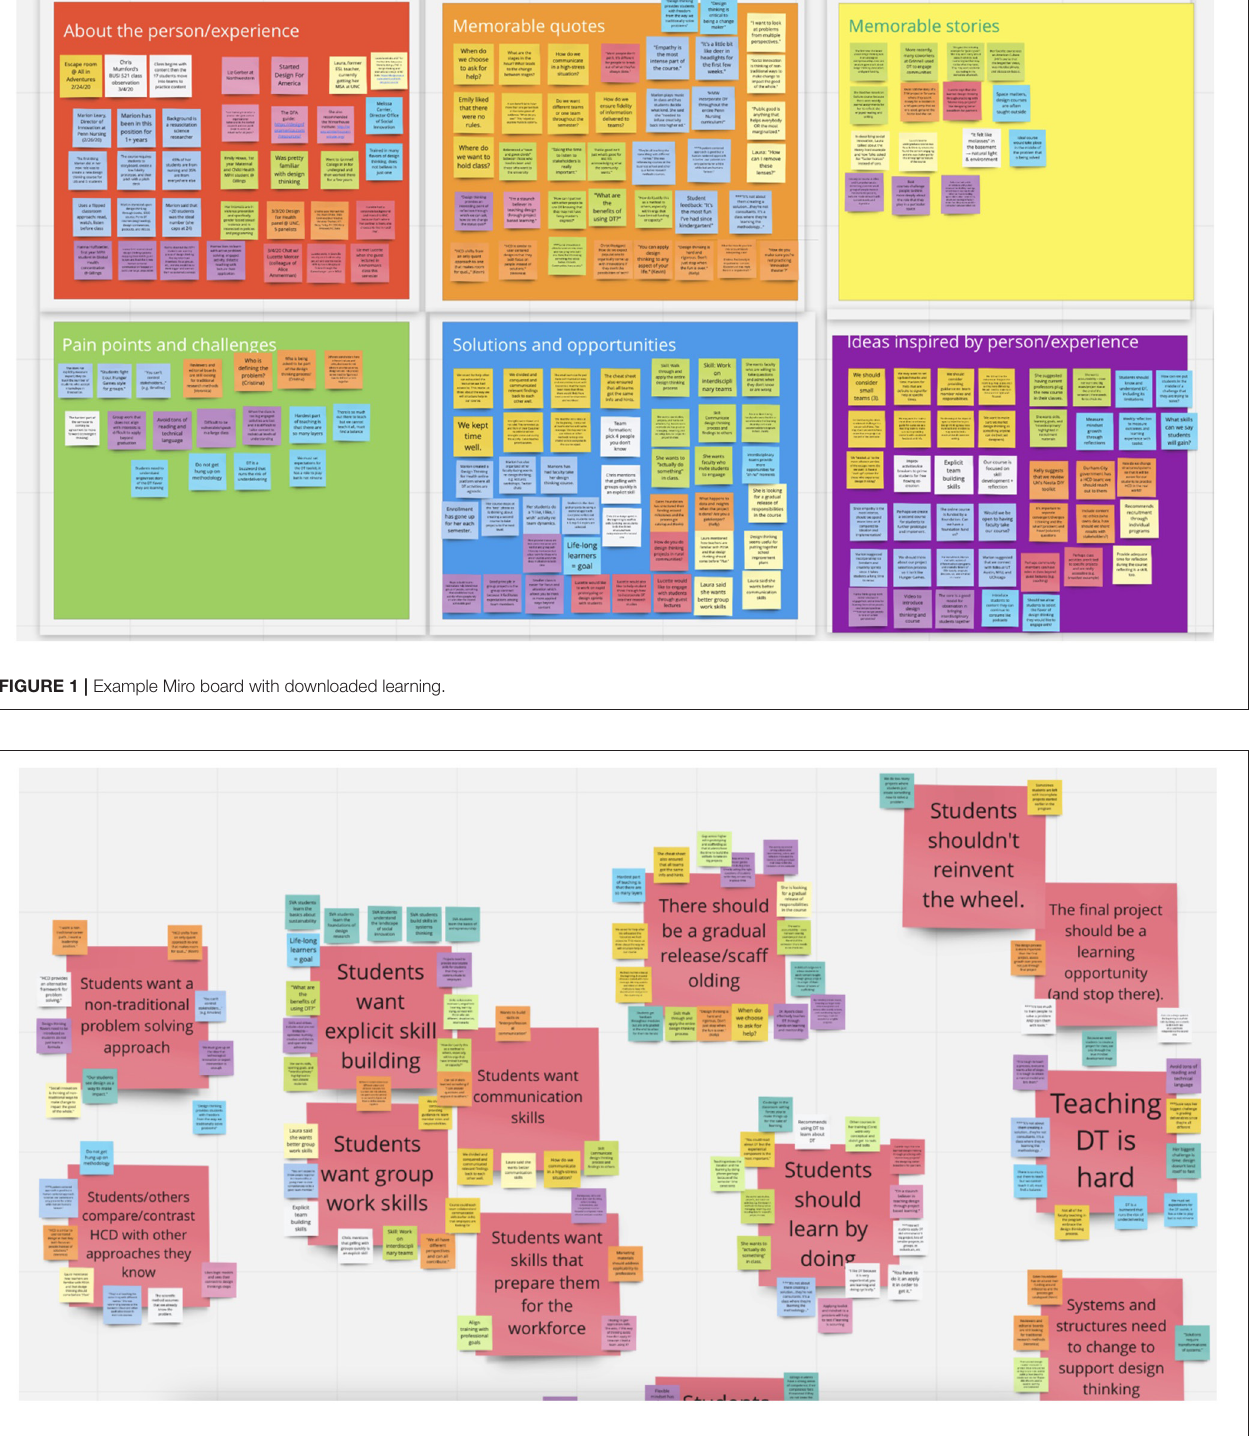
FIGURE 2 | Example Miro board with clusters and